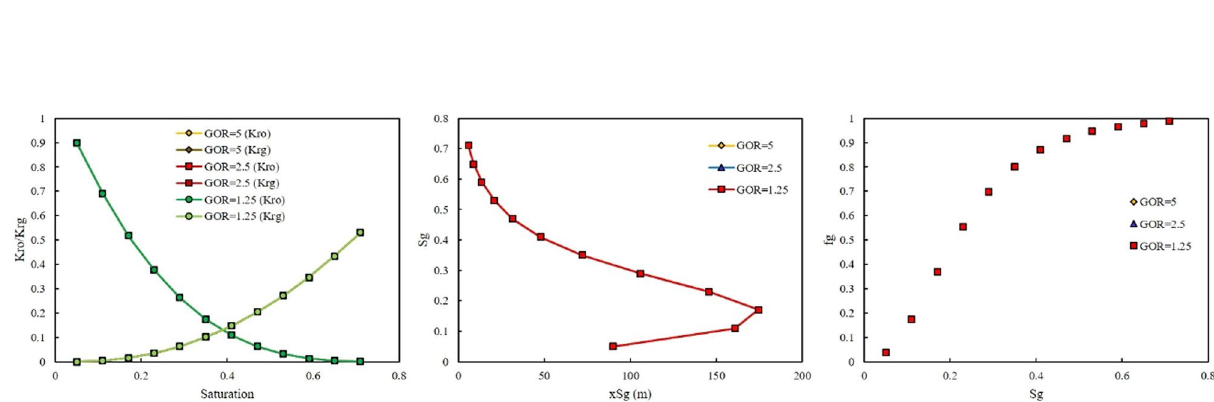
Figure 11. Effect of GOR of NGL on relative permeability, saturation profile, and fractional flow curve at an injection pressure of 500